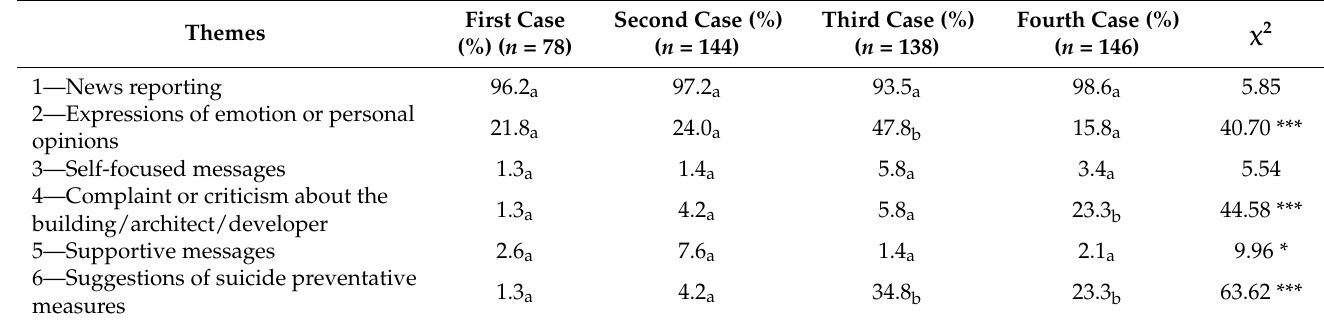
Table 2. Summaries of the distribution of themes in tweets across the four cases.